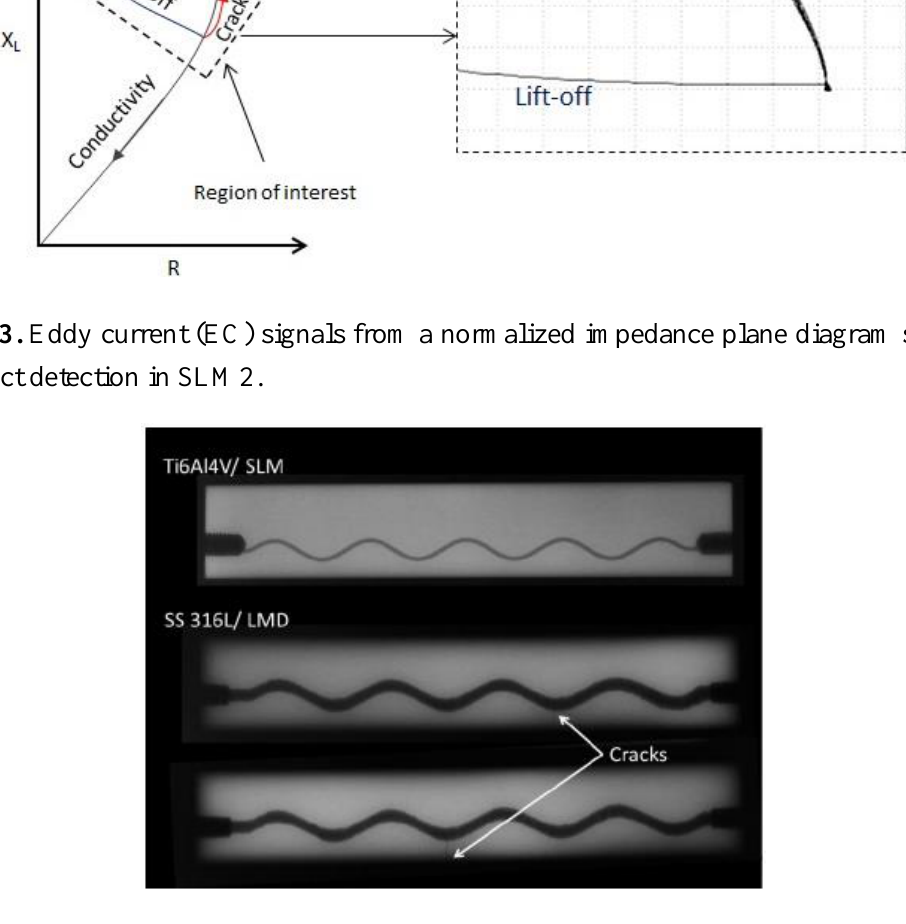
Figure 4. Radiographic images of the four-point bending specimens produced by selective laser melting (SLM) and laser metal deposition (LMD) after the crack detection of the effective structural health monitoring (eSHM)